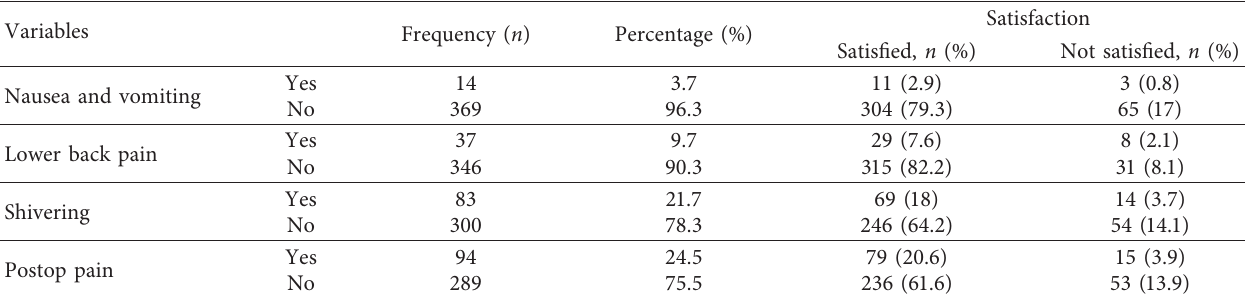
Table 4: Postoperative anesthesia-related factors of parturients at University of Gondar Comprehensive Specialized Hospital, Northwest Ethiopia, 2019 ( N �